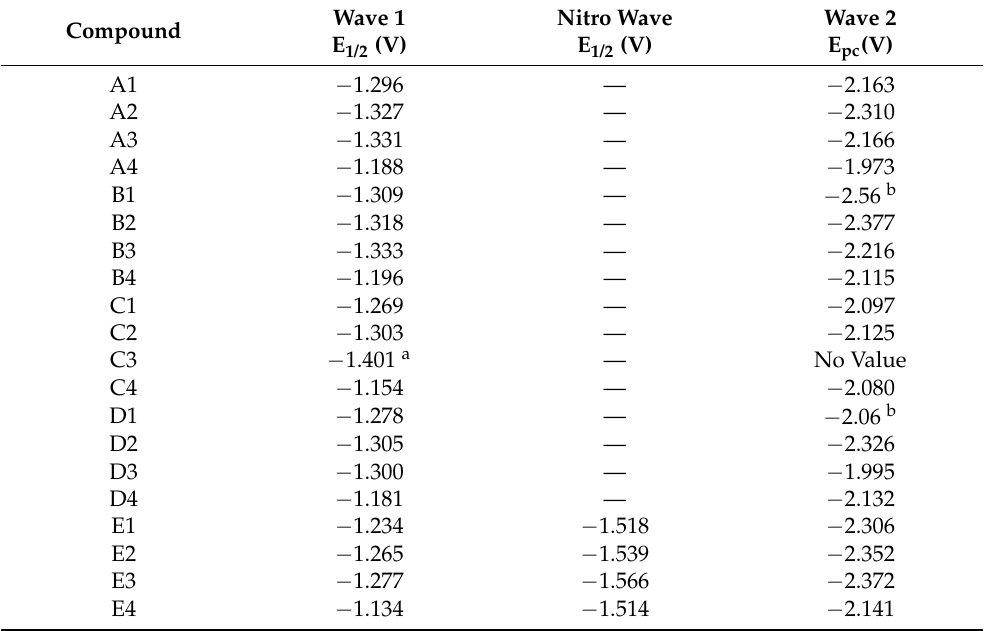
Table 4. The experimental electrochemical wave 1, nitro wave, and wave 2 reduction potentials ( ε (cid:48) cell , in volts) measured versus the Fc/Fc + electrode.